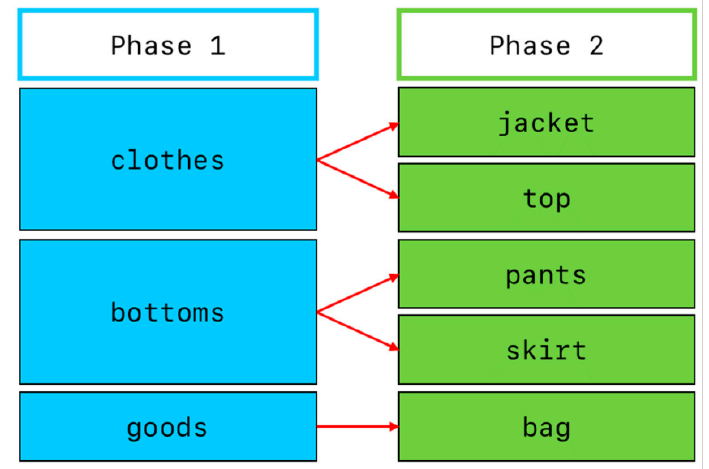
Figure 3. Category structure of two-phase fashion apparel